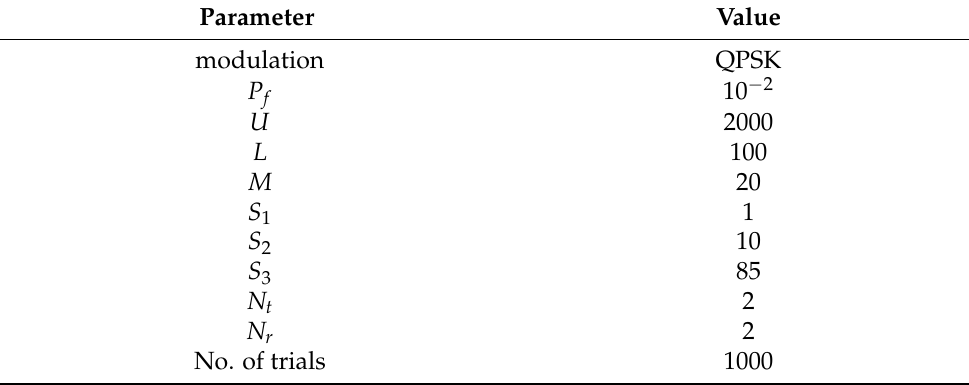
Table 1 collects all parameters concurring to describe the simulation setup. Table 1. Simulation